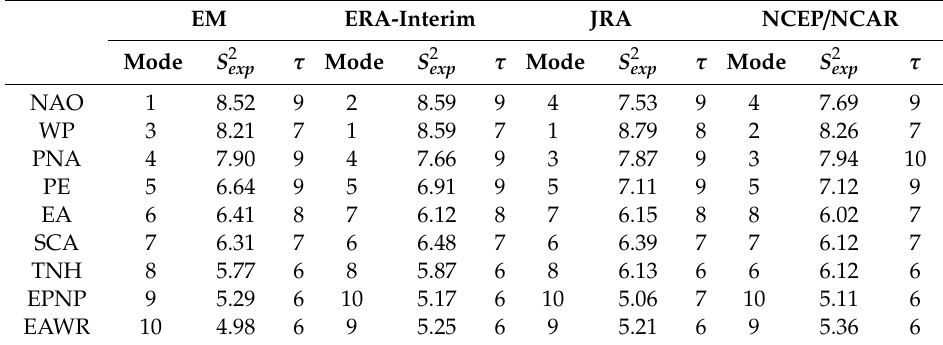
Table 1. Explained variance S 2 exp (%) of the principal component time series, and ranking and e -folding timescale τ (days) for the nine teleconnection patterns obtained from three reanalysis datasets over the winter periods from 1979 to 2018.